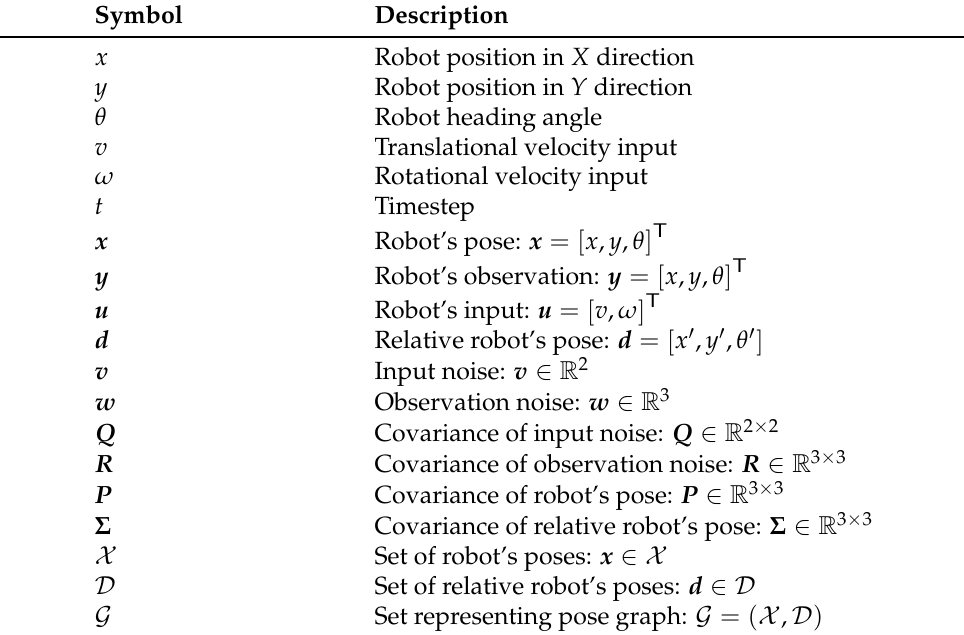
Table 1. Variable descriptions.